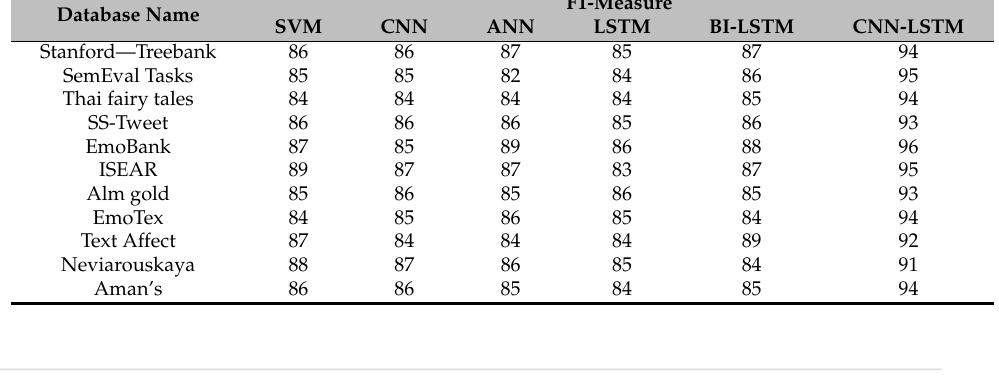
Table 7. Performance analysis for BOW + IF-IDF with CNN-LSTM based on F1-measure.